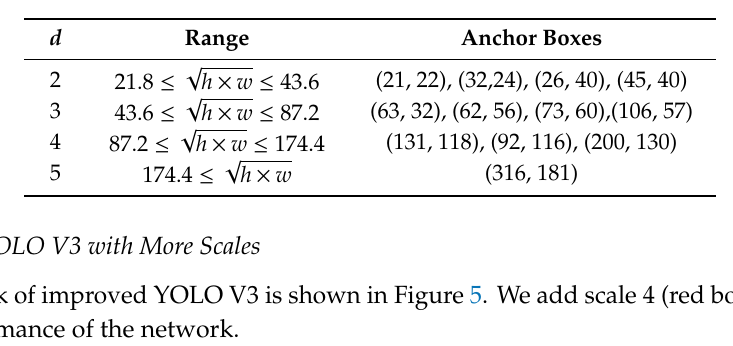
Table 4. The allocation of clusters on KITTI dataset at each scale.